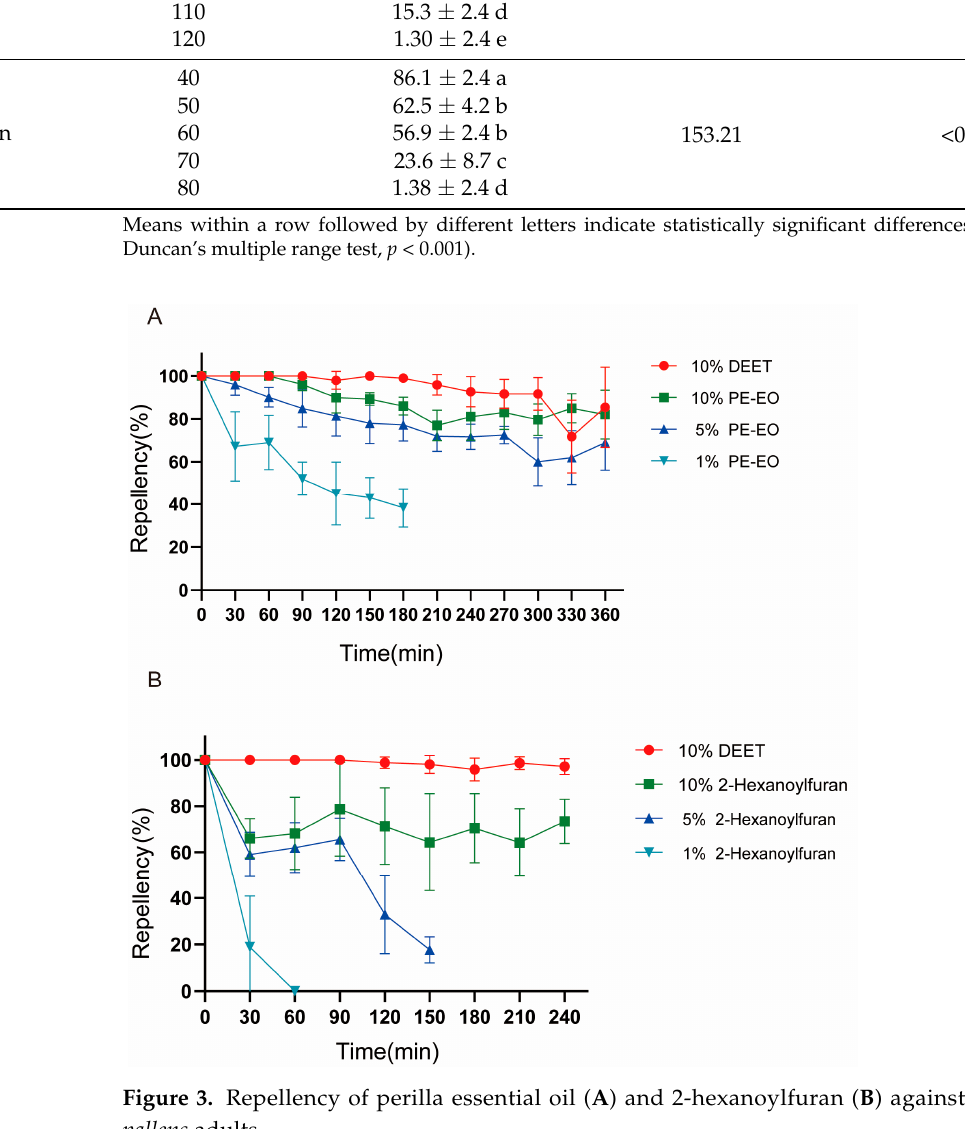
Table 3. Oviposition activity of perilla essential oil (PE-EO) and 2-hexanoylfuran against Culex pipiens pallens. Treatment